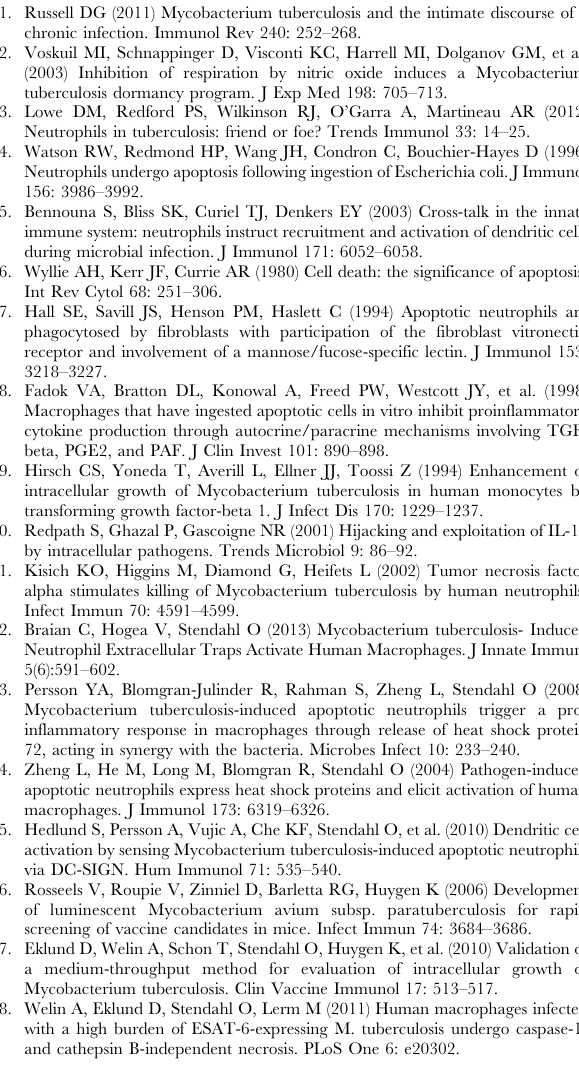
Figure S2 The effect of increasing MOI on uptake of M. tuberculosis . hMDMs were stimulated with FITC labeled c -irr Mtb at different ratios and analyzed by flow cytometry. Data are presented as percentage of hMDMs that had phagocytosed at least one bacterium (FITC + ). Values represent mean + SEM (n=